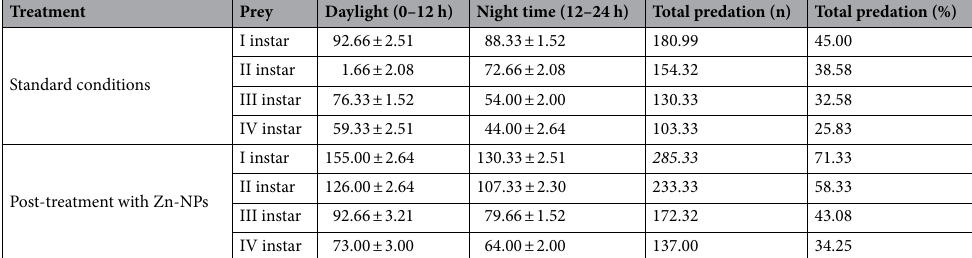
Table 3. Predation efficiency of Gambusia affinis on An. stephensi larvae in standard conditions and post- treatment of ZnO NPs. Predation rates are means ± SD of 3 replicates (1 fish vs. 400 mosquitoes per replicate). Control was clean water without G. affinis fishes. Within the column, means followed by the same letter are not significantly different (weighted generalized linear model , P < 0.05 ).